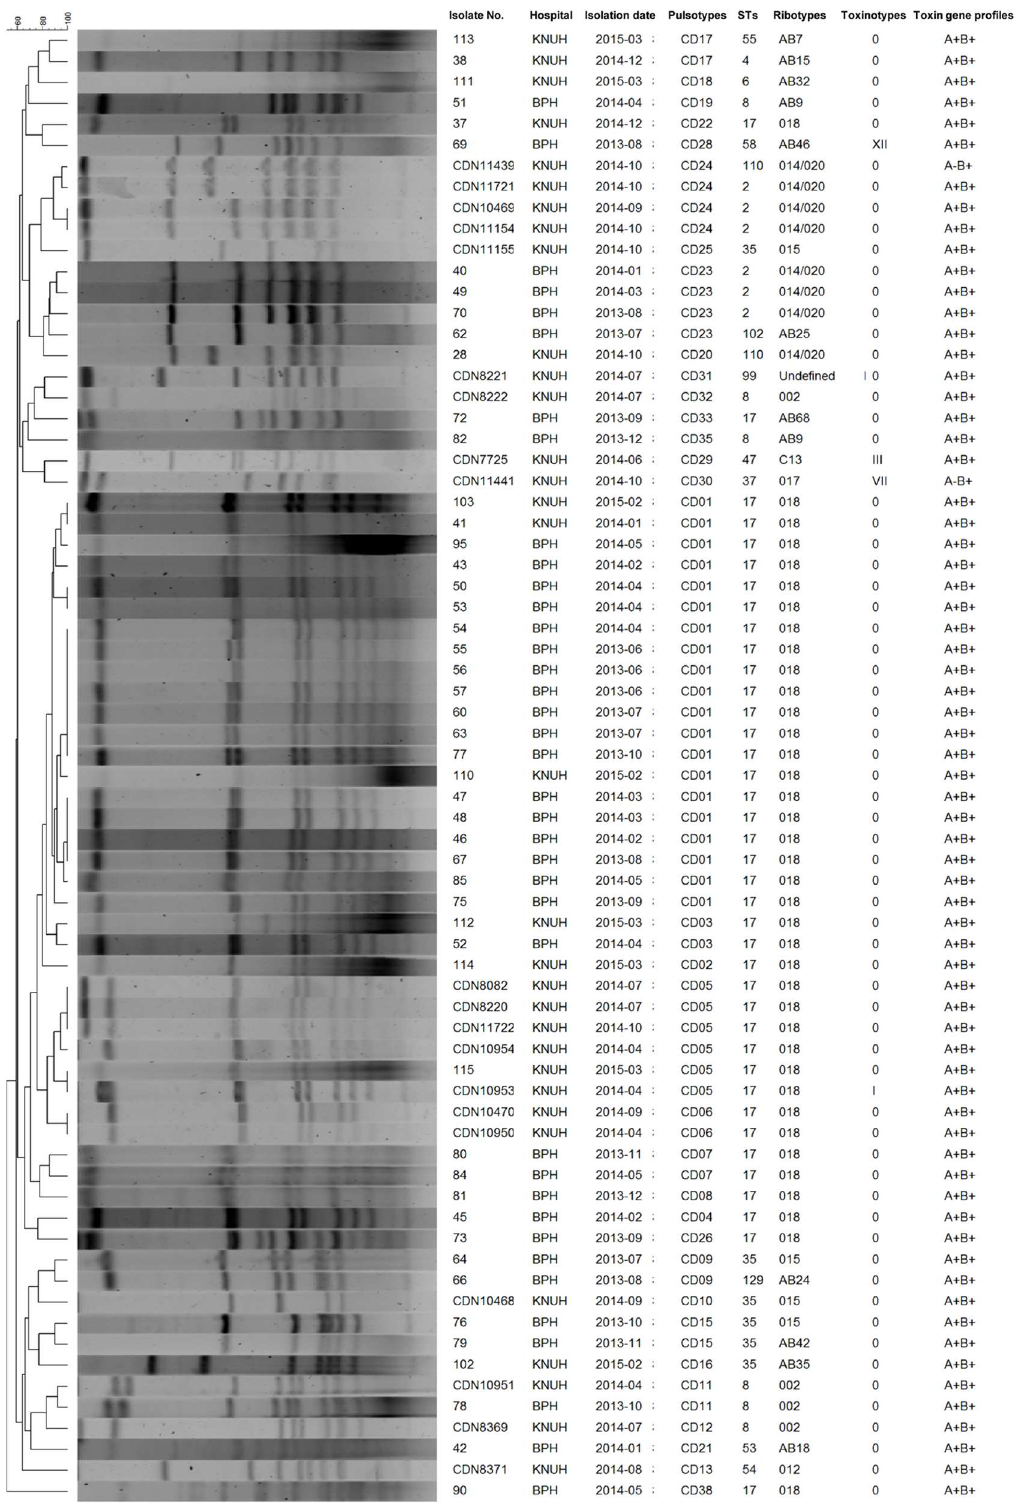
Fig 2. Dendrogram showing 33 pulsotypes obtained by pulsed-field gel electrophoresis of 70 C . difficile isolates. Genomic DNA was digested with Sma I. The unweighted pair group method with arithmetic mean clustering method was used with the Dice coefficient with positiontoleranceand optimizationof 1.2%. Pulsotypes were arbitrarily